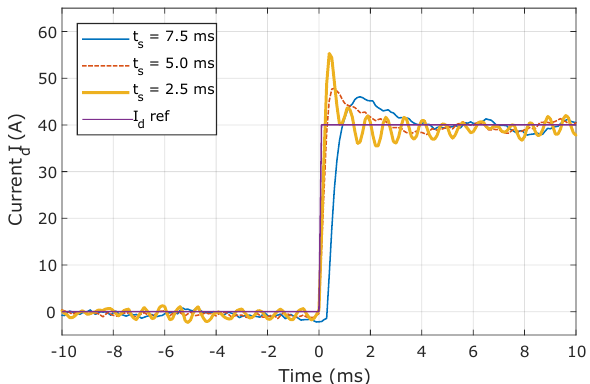
Figure 11. Simulated step response with a plant to model inductance ratio of 0.5.